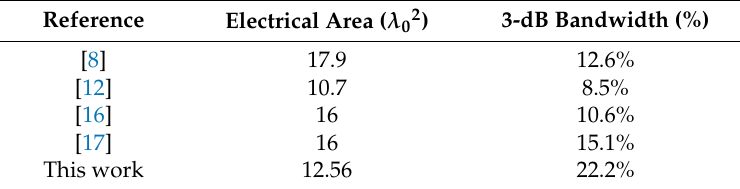
Figure 11. ( a ) Gain bandwidth comparison between FPRA with planar superstrate and paraboloidal superstrate; ( b ) simulated and measured gain–frequency response for the proposed FPRA. Table 1. Comparison of the 3-dB gain bandwidth between a few FPRAs in literatures and the FPRA proposed in this